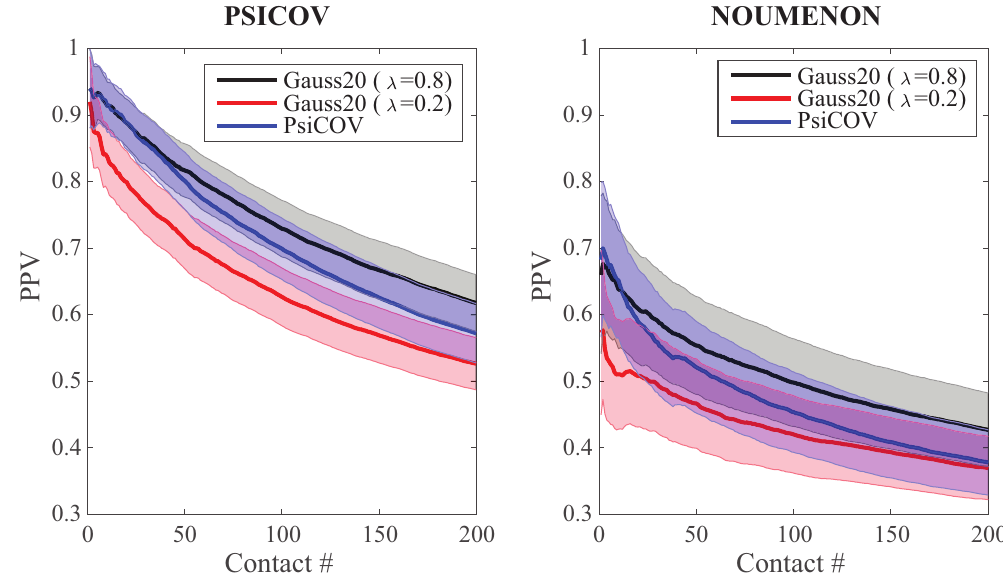
Figure 1. Precision Positive Values (PPV) plotted against the number of predicted contacts for the PSICOV dataset ( left ) and the NOUMENON dataset ( right ). PPV ( k ) is the rate of correctly predicted contacts within the first k contacts. Data for the Gaussian models were generated with GaussCovar, with a 20-dimensional binarized vector representing amino acids, with λ = 0.8 (black curve), or λ = 0.2 (red curve). Data for the PSICOV predictions (blue curve) on the PSICOV dataset were obtained from the data provided by the authors [26], while the similar data on the NOUMENON dataset were generated by running directly PSICOV (see text for details). All PPV curves are arithmetic means over 150 protein families. The shaded areas represent standard